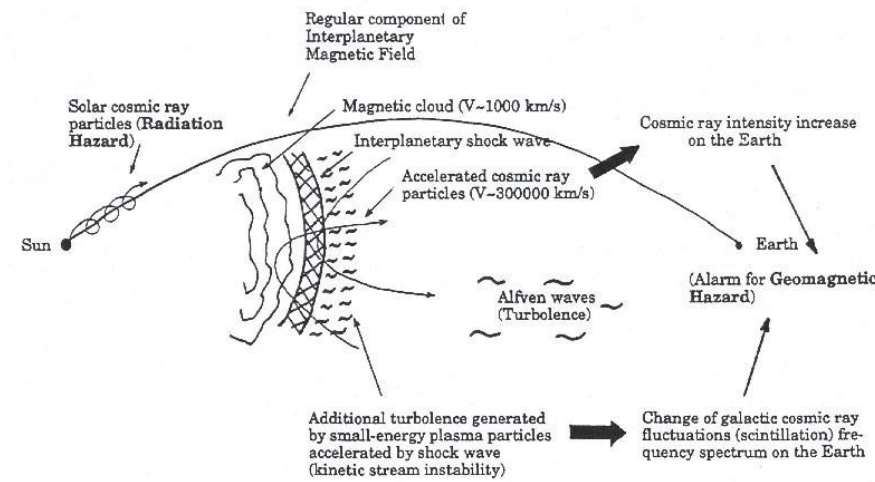
Fig. 3. The scheme of possible precursory effects in